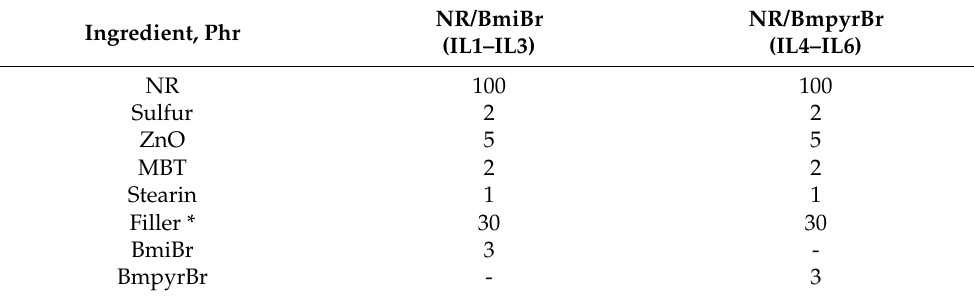
Table 3. General recipes of NR compounds containing ionic liquids (phr); (BmiBr,